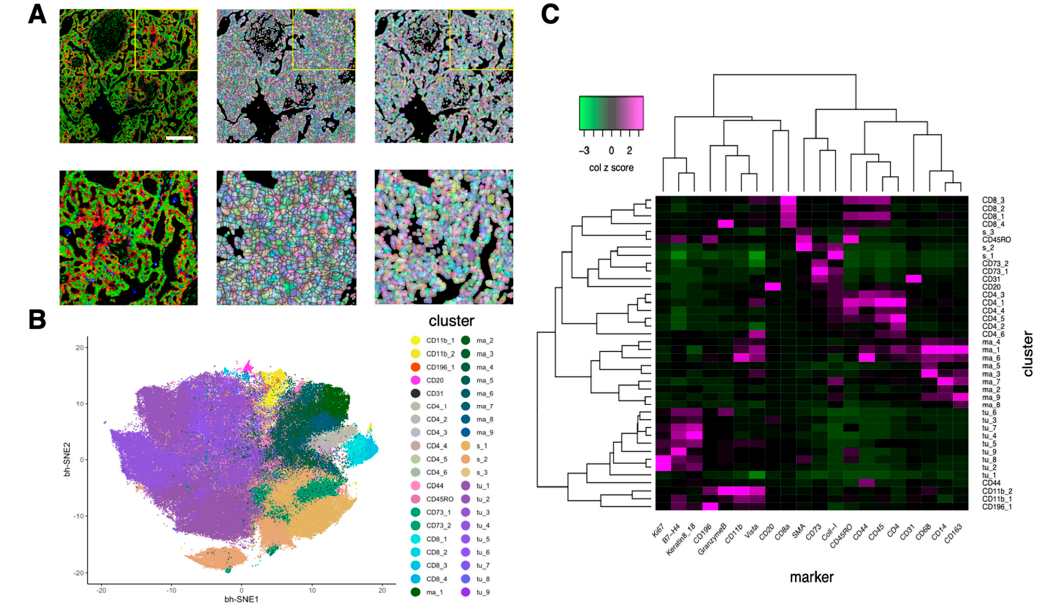
Figure 3. Cell segmentation by mask-R-CNN and cell subtype annotation based on marker expression. ( A ). Comparison of watershed segmentation and mask-R-CNN segmentation. Left, imaging mass cytometry (IMC) image; red: Keratin8/18, green: histone H3, blue: CD68. Middle, watershed segmentation. Right, mask-R-CNN segmentation. Bottom three images are the zoomed-in images of the yellow rectangle region of the top three images. White scale bar, 200 µm. ( B ). Two-dimensional bh-SNE representation of multiplexed IMC data highlighted by cell subtypes generated by phenograph clusterings. Each dot represents one cell. ( C ). Heatmap showing the median marker expression (z-scored by column) of each cluster (cell subtype). Twenty markers and 40 clusters were ordered by hierarchical clustering with the distance based on Pearson correlation.